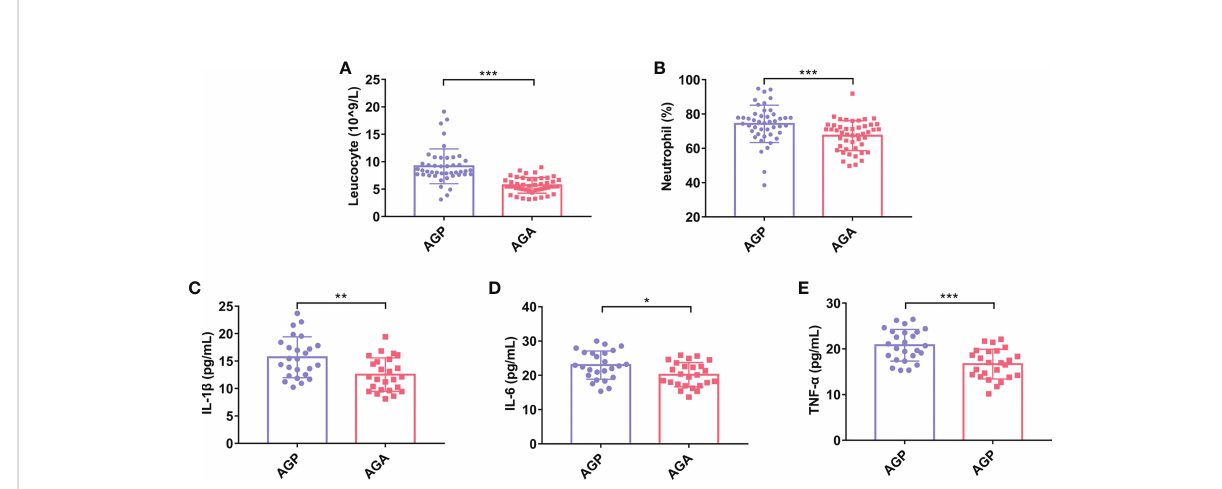
FIGURE 2 C butyricum inhibited in fl ammatory response in patients with gastric cancer after gastrectomy. (A) Leukocyte; (B) Percentage of Neutrophil; (C) IL-1 b ; (D) IL-6; (E) TNF- a . AGP, gastric cancer patients and treatment with the placebo after gastrectomy (n=45); AGA, gastric cancer patients and treatment with the C butyricum after gastrectomy (n=47). Data are presented as means ± SD. * P < 0.05, ** P < 0.01, *** P < 0.001. IL, interleukin; TNF, tumor necrosis